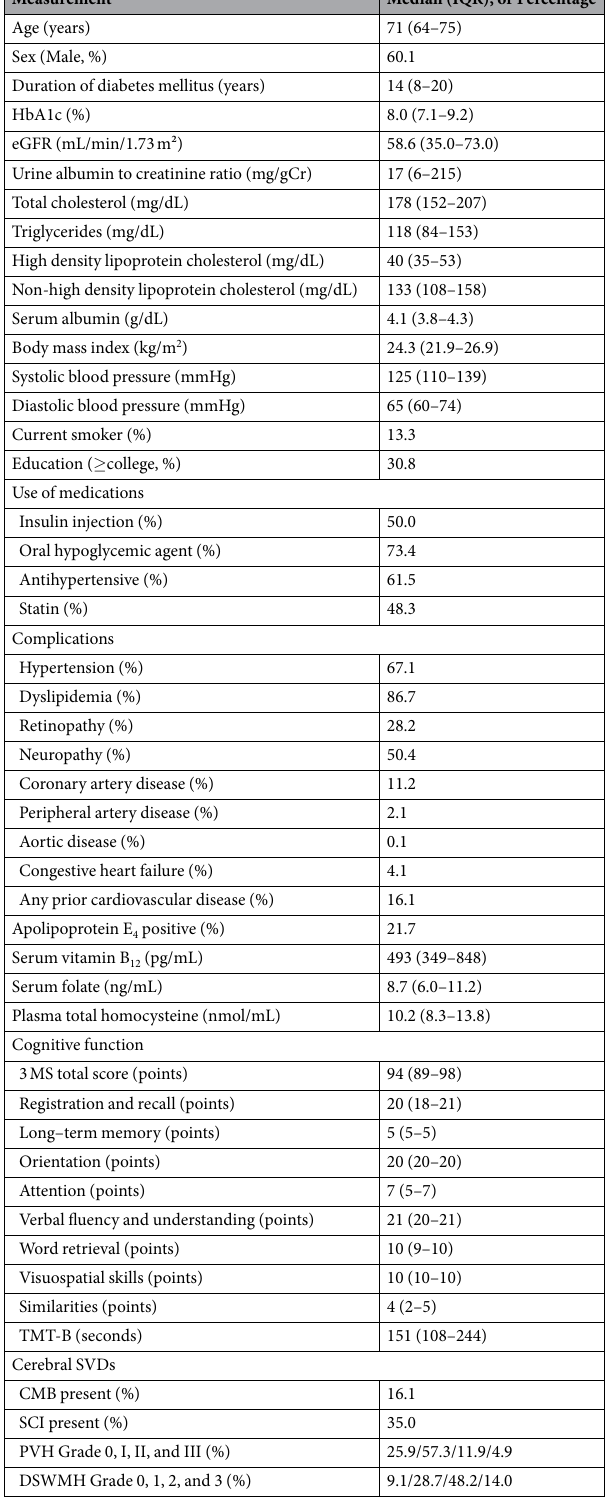
Table 1. Clinical characteristics of the study participants. The table gives percentage for categorical variables and median (IQR) for continuous variables. Abbreviations are: IQR, interquartile range; eGFR, estimated glomerular filtration rate; HbA1c, hemoglobin A1c; 3 MS, Modified Mini-Mental State examination; TMT-B, Trail Making Test B; SVD, small vessel disease; CMB, cerebral microbleed; SCI, silent cerebral infarction; PVH, periventricular hyperintensity; DSWMH, deep and subcortical white matter